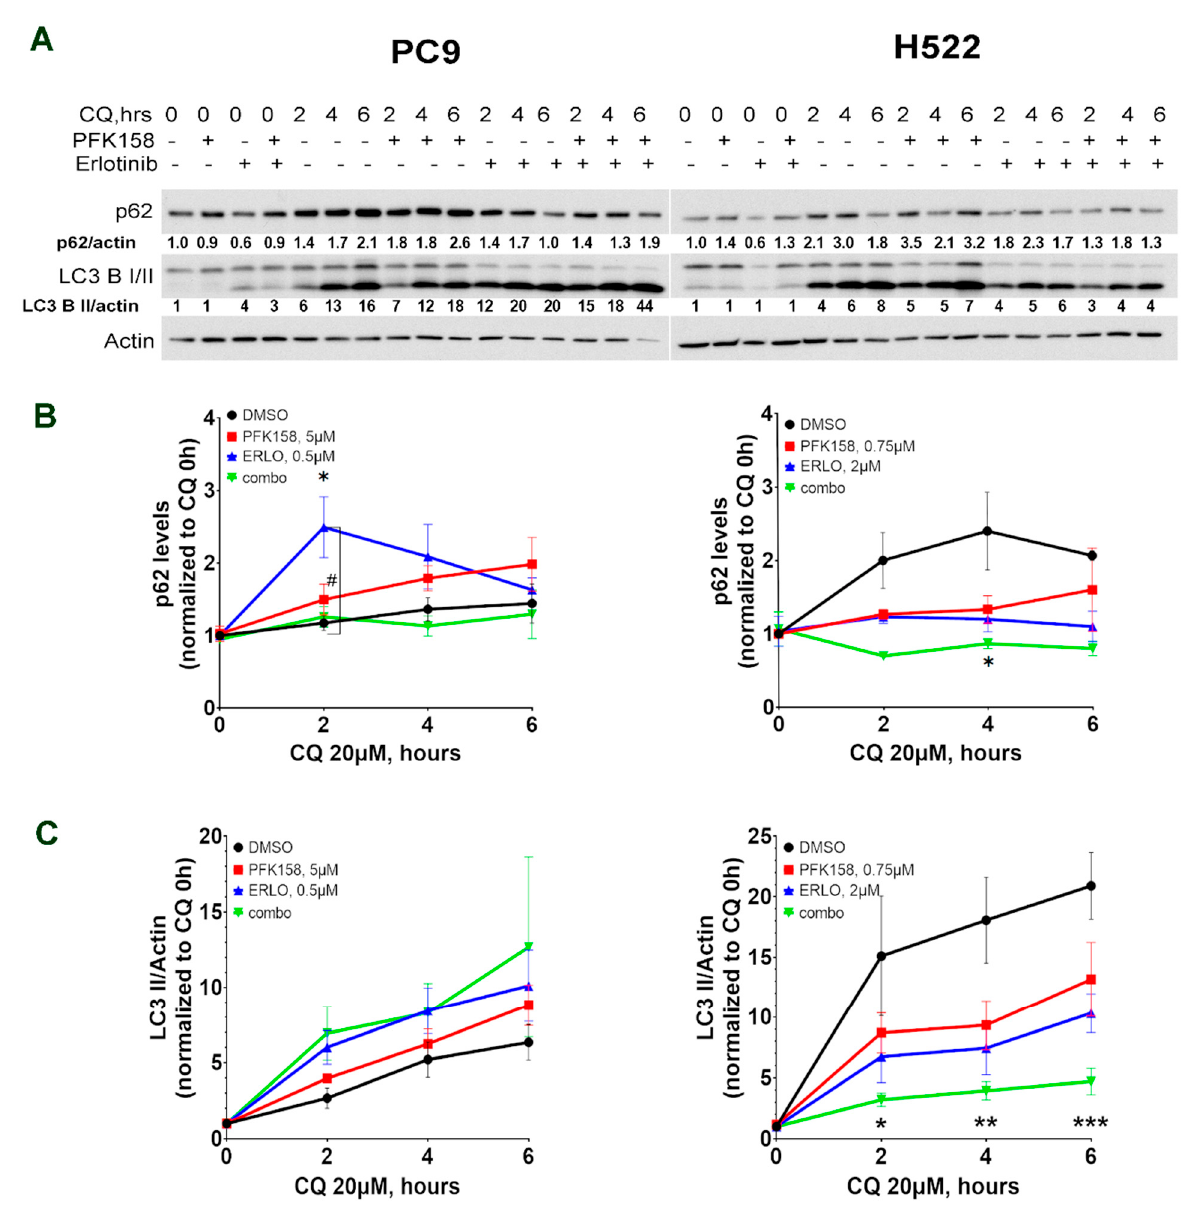
Figure 3. PFKFB3 inhibition impairs p62 turnover in TKI-treated cells in NSCLCs. PC9 and H522 cells were treated with erlotinib (PC9: 0.5 μ M; H522: 2 μ M) and/or PFK158 (PC9: 5 μ M; H522: 0.75 μ M) alone or in combination for 24 h followed by exposure to 100 μ M CQ for 0–6 h. Whole cell lysates were immunoblotted with the indicated antibodies. Images shown control treated cells (DMSO, PC9 or H522) ( A ). p62 levels were normalized to loading control (actin) and to the levels